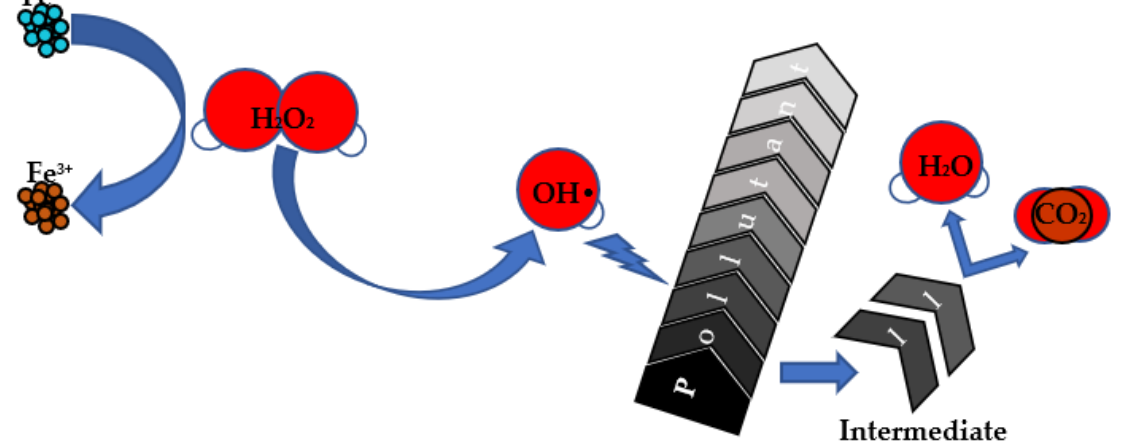
Figure 1. Scheme of the Fenton process. In general, the multiple reactions involved can be summa- rized by Equations (1) and (2) [40,41].